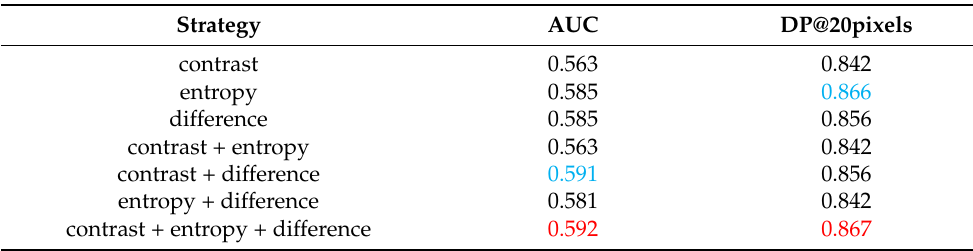
Table 1. Tracking performance comparison of channel selection strategies. The best two results are marked with red and blue. Strategy AUC DP@20pixels contrast 0.563